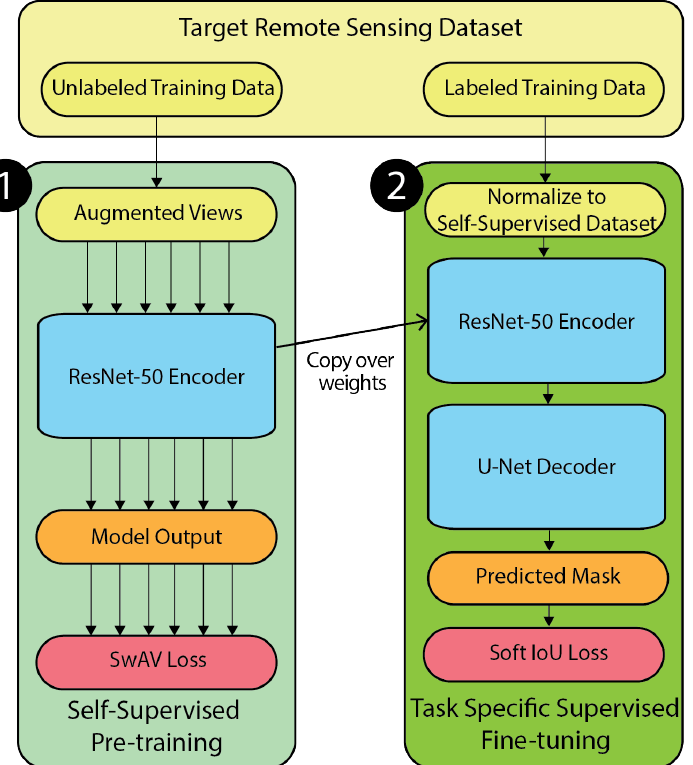
Figure 1. The model architectures used in our experiments. In the self-supervised pre-training step (1), the training data were fed through a ResNet-50 architecture, and the SwAV loss from the fully connected layer was used to train the model. Once the ResNet-50 encoder was trained, the fully connected layer was detached, and the model weights were saved. (2) To fine-tune, the ResNet-50 model was attached to a U-Net decoder, with the ResNet-50 weights coming from the previous step and the remaining weights randomly initialized. During training, both the U-Net and ResNet-50 weights were updated using the soft-IoU loss between the actual and the predicted